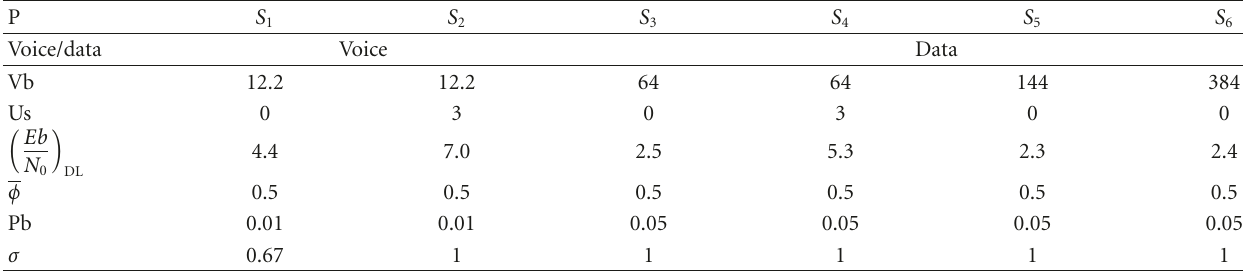
Table 2: Service parameters.